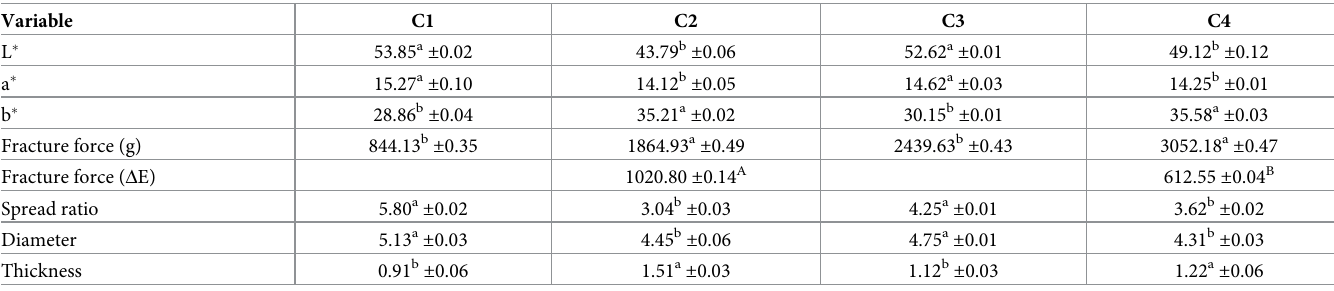
Table 4. Color, hardness and spread